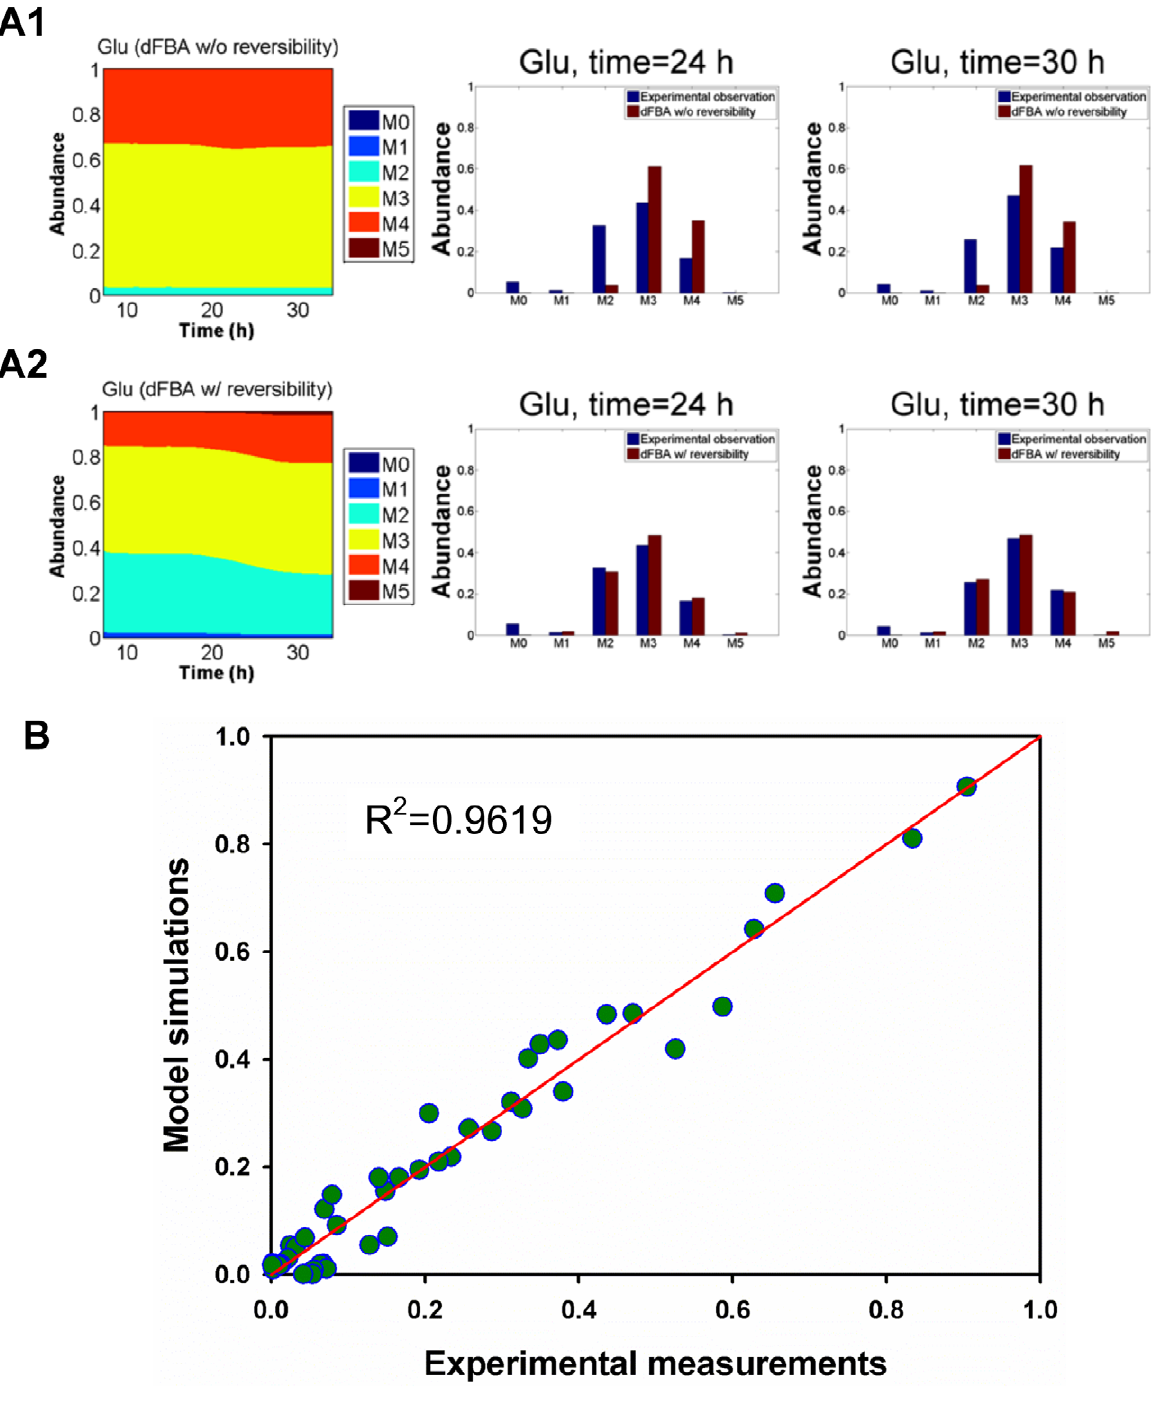
Figure 5. Experimentally observed and simulated isotopomer labeling patterns [M-57] + in proteinogenic amino acids. The standard error for GC-MS measurement was below 0.02. A1 : dynamic isotopomer simulation for glutamate from dFBA without considering reaction reversibility (dFBA w/o reversibility). A2 : dynamic isotopomer simulation for glutamate from dFBA considering reaction reversibility (dFBA w/ reversibility). Bar plot: comparison of experimentally observed isotopomer labeling to simulated isotopomer labeling patterns of glutamate ( A1 : without considering reaction reversibility; A2 : considering reaction reversibility). B : The model fitting of the isotopomer labeling data of five key amino acids (Ala, Gly, Ser, Asp, and Glu) at t=24 and 30